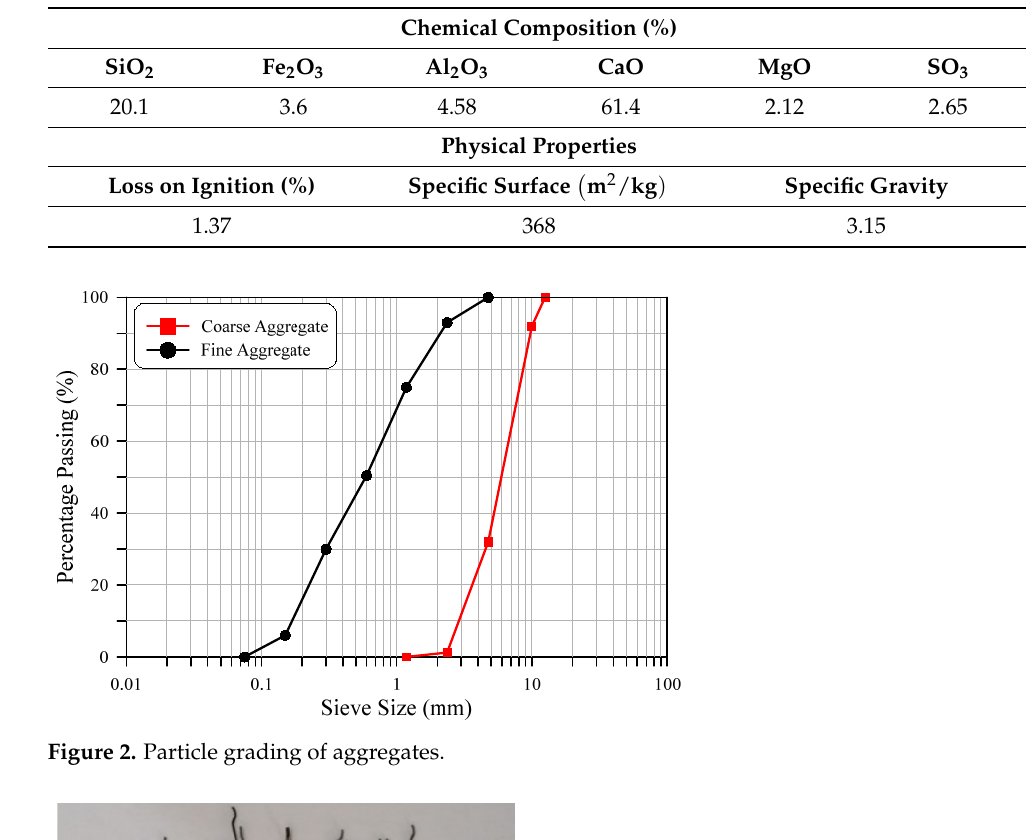
Table 1. Properties of the used Portland cement. Table 2. Concrete mixtures (kg/m 3 ).